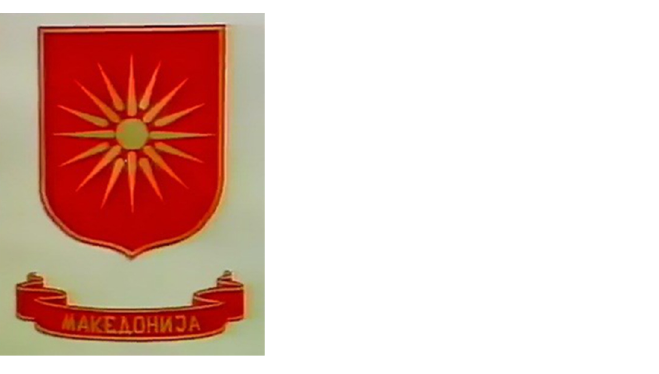
Figure 3. Todor Petrov’s proposal accepted by the Commission (July 1992).